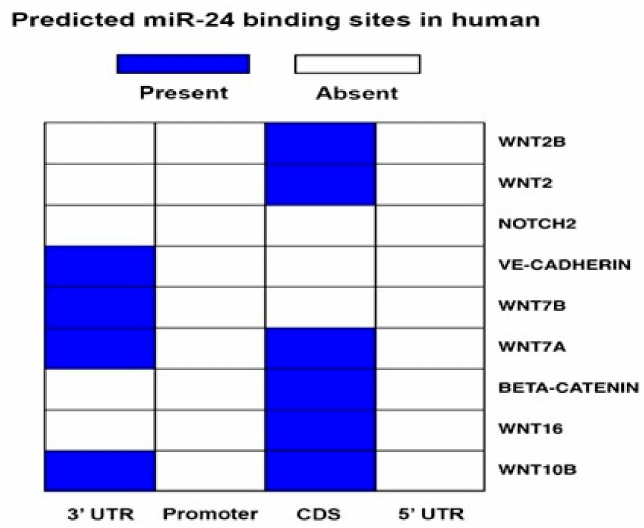
Figure 7. miR-24-3p and Wnt / β -catenin binding prediction. The table shows the target genes prediction related to the Wnt / β -catenin pathway in human (left) and mouse. The prediction was performed using mirWalk